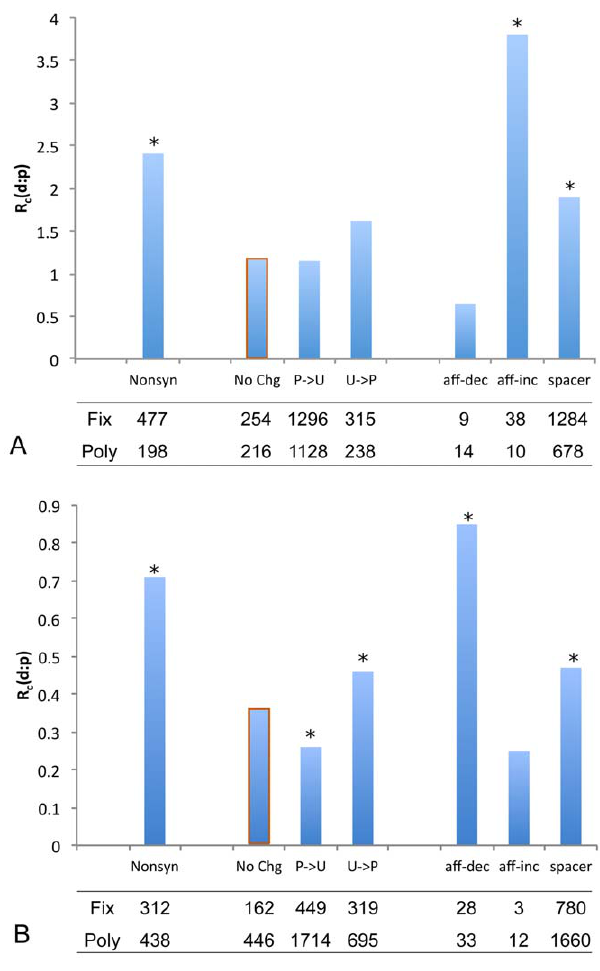
Figure 2. Substitution-to-polymorphism ratios in mel and sim . R c ( d : p ) ratios between number of fixed mutations (fix) in each class and number of common polymorphisms (poly; with derived allele frequency w 0.15; see text for justification) for (A) mel and (B) sim . In sim , only TFBS with a predicted ancestral PWM score w 2 are included (see text). Synonymous changes are categorized according the predicted effect of a mutation on codon preference (P: Preferred codon; U: Unpreferred codon; No Chg: P ? P and U ? U). Consistent with previous reports, we find evidence for selection on biased codon usage in sim but not mel . Statistical significance of each class relative to the neutral reference (the No-Change class, outlined in orange) is evaluated by Fishers exact test. Classes that are significant at a 0.05 level (two- sided test) are marked with an asterisk above the bar.